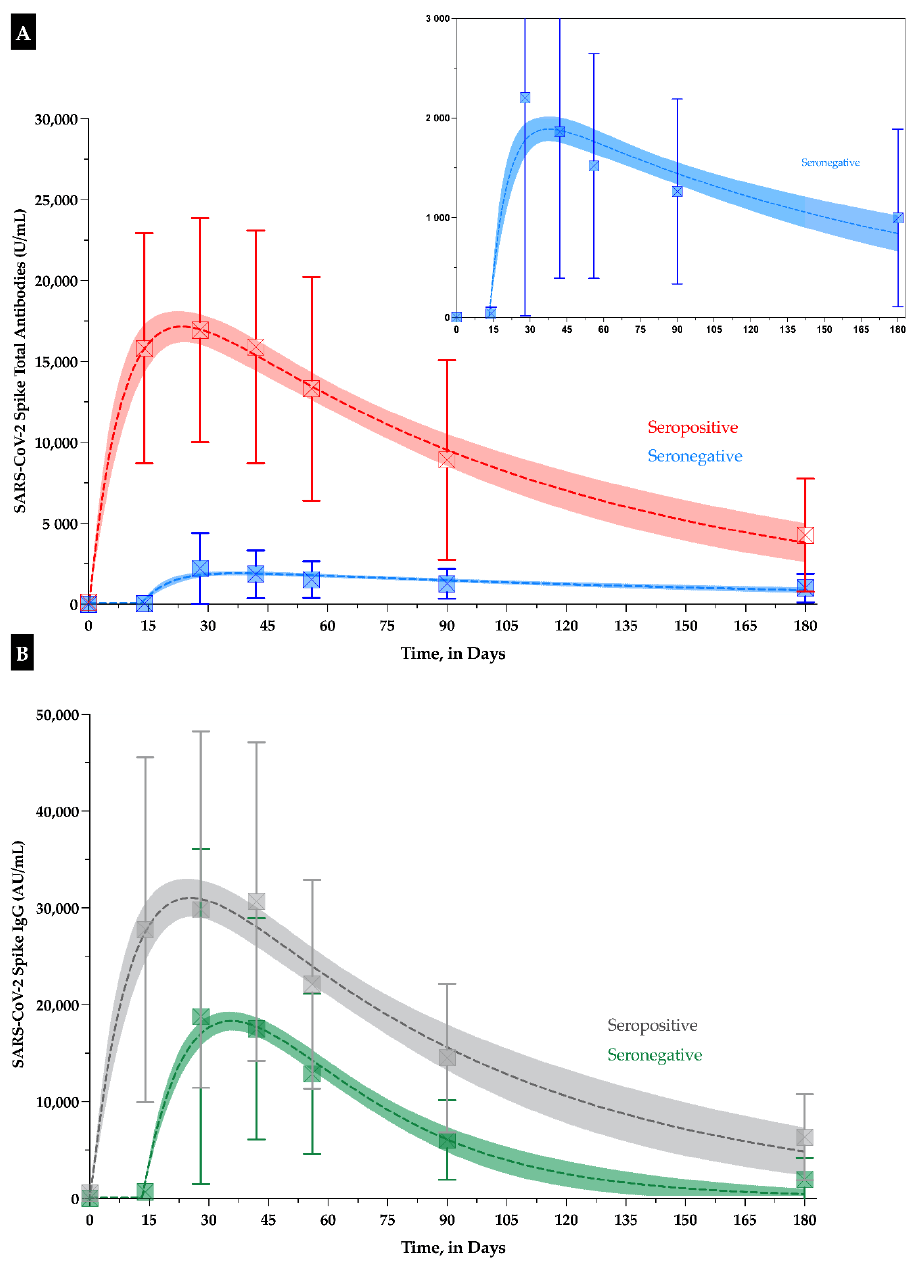
Figure 2. (Previous page). Kinetics models of ( A ) total antibodies and ( B ) IgG serological response. A zoom of the seronegative population is presented in the right-upper part of the Figure A. Means plus/minus standard deviation are shown at the different timepoints. The magnitude of the re- sponse depends on the analytical kit and the difference between COVID-19 naïve and seropositive individuals is less marked with IgG than with total antibodies.